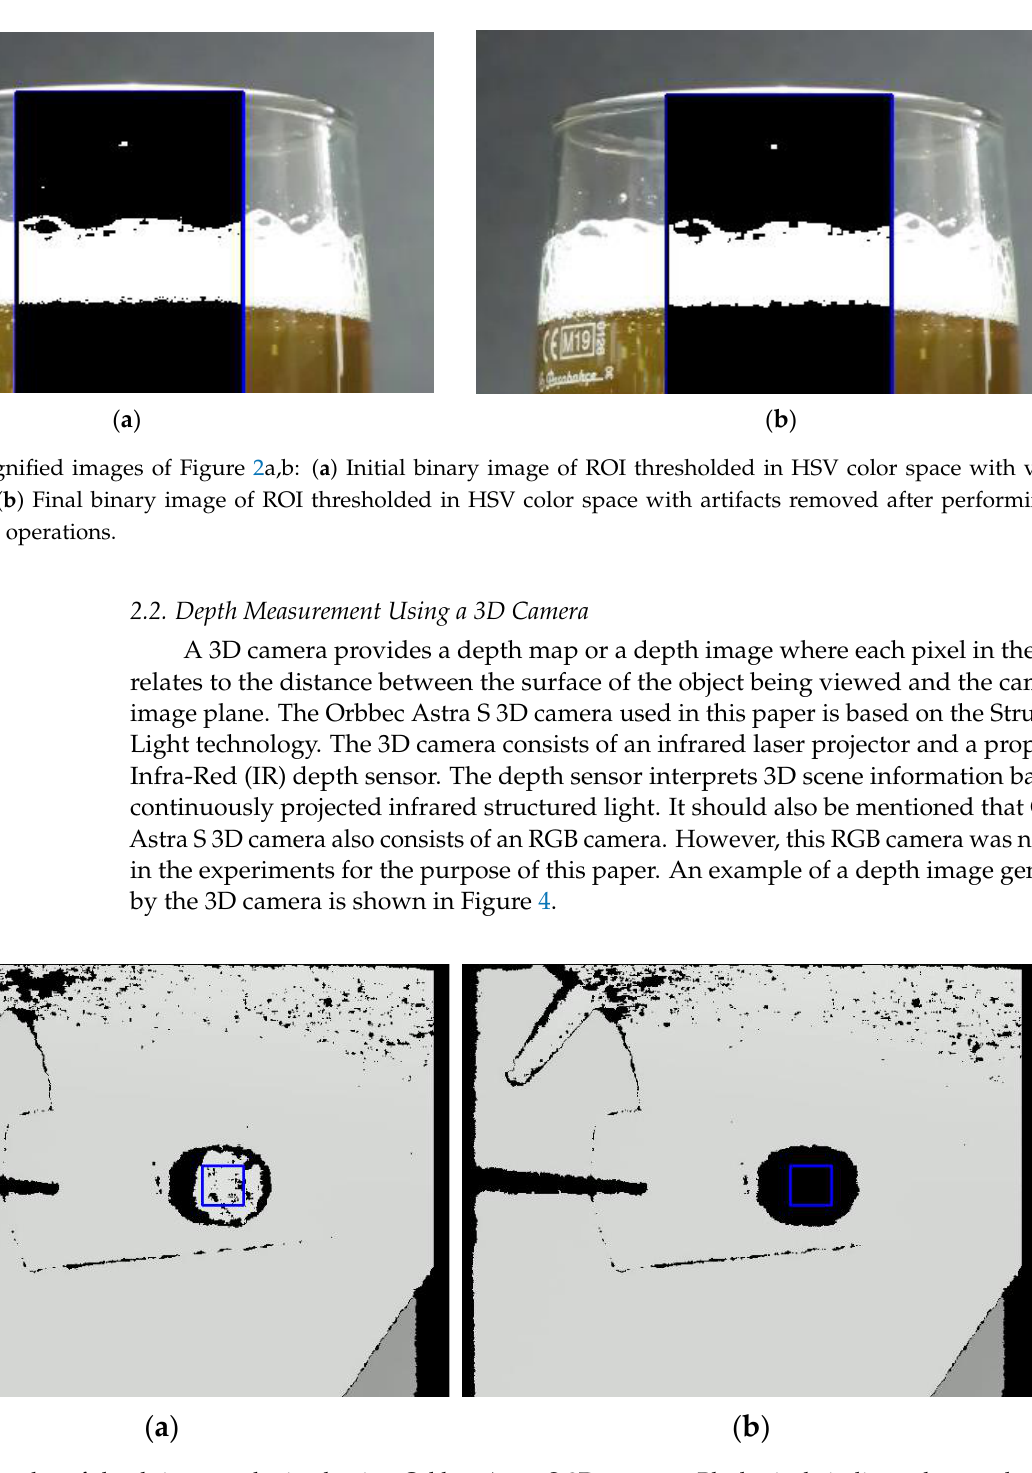
Figure 4. Examples of depth images obtained using Orbbec Astra S 3D camera. Black pixels indicate that no depth information exists: ( a ) ROI defined in the middle of the glass containing foam; ( b ) the same view after a few minutes when the foam disappears.